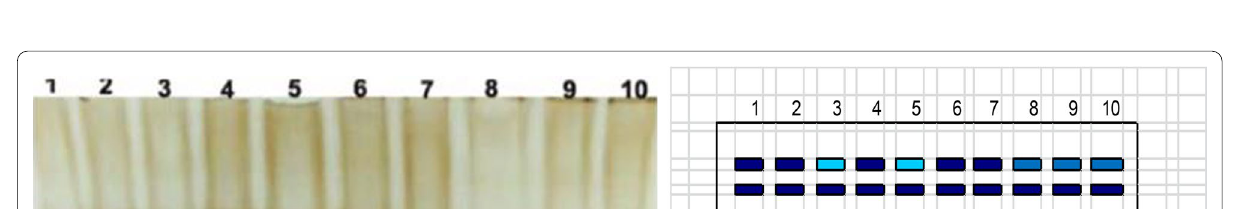
Fig. 5 Effect of F. oxysporum and endophytic isolates on (MDA) (nmol g − 1 fresh weight); (H 2 O 2 ) (mg g − 1 fresh weight); POD (unit/g) f. wt./h. and PPO(unit/g) f. wt./ h. of tomato plants. Data presented as means P 0.05. (T1-Healthy control; T2-Infected control; T3-Healthy treated with A. flavus ; T4-Healthy treated with A. nidulance ; T5-Healthy treated with A. ≤ fumigatus ; T6-Healthy treated with combination of A. flavus, A. nidulance and A. fumigatus ; T7-Infected treated with A. flavus ; T8-Infected treated with